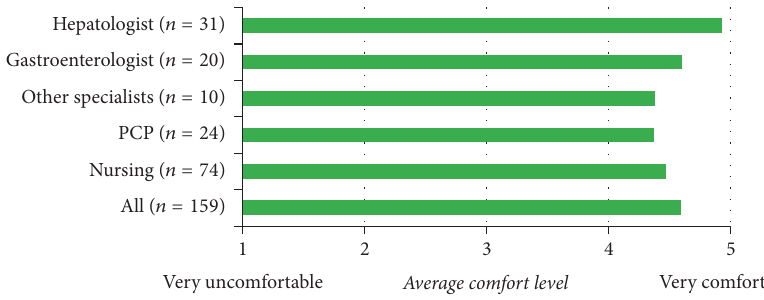
Figure 3: Level of comfort of the participants in explaining the necessity of hepatitis C testing.